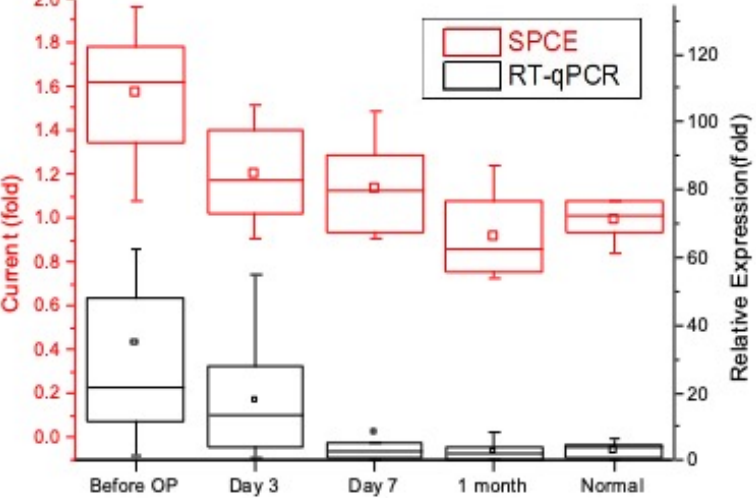
Figure 7. Detected miR-21 in colorectal cancer patients before and after surgery with RT-qPCR analysis.